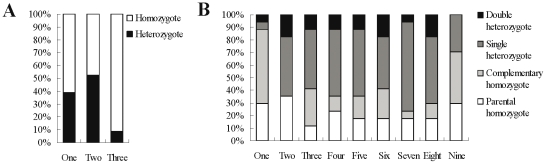
The relative performance of all kinds of genotypes of QTL (A) and epistatic interactions (B) for seed yield.The abscissa and ordinate respectively represents the relative place and the proportion of each type of genotype. The three genotypes of each QTL in reconstructed F2 population were classified into two types: homozygote and heterozygote. The nine genotypes of each epistatic interaction in reconstructed F2 population were classified into four types: parental homozygote, complementary homozygote, single heterozygote and double heterozygote.